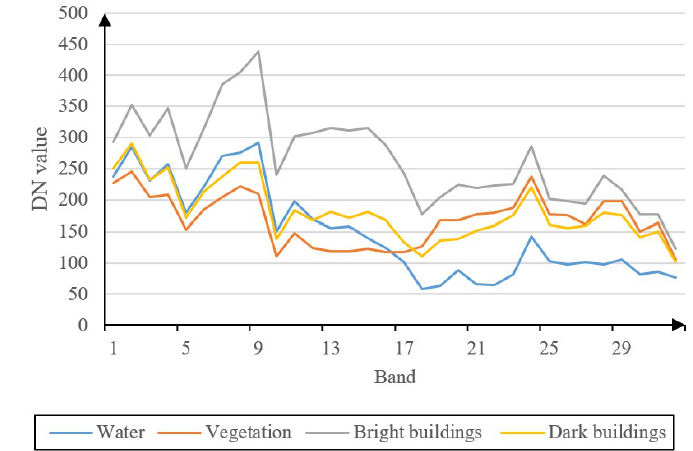
Figure 4. Spectral reflectance of Water, vegetation, dark and bright buildings of the HSI in the study